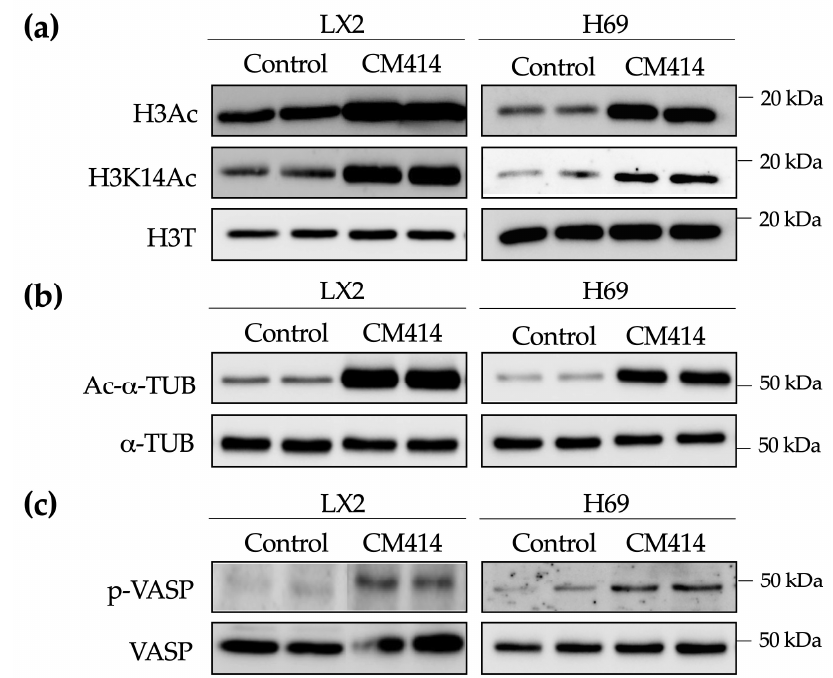
Figure 5. Evaluation of the on-target effects of CM414 in LX2 and H69 cells. ( a ) immunoblot analyses of total histone 3 acetylation (H3Ac), histone 3 acetylation at lys 14 (H3K14Ac) and total histone 3 (H3T) protein levels in LX2 (left panel) and H69 (right panel) cells treated for 1 h with CM414 (5 μM). ( b ) immunoblot analyses of acetylated-α-tubulin (Ac-α-TUB) and α-tubulin (α-TUB) protein levels in LX2 (left panel) and H69 (right panel) cells treated for 24 h with CM414 (5 μM). ( c ) immunoblot analyses of phospho-vasodilator-stimulated phosphoprotein (VASP) and VASP protein levels in LX2 (left panel) and H69 (right panel) cells treated for 24 h with CM414 (5 μM). Representative blots of three experiments performed in duplicate are shown.